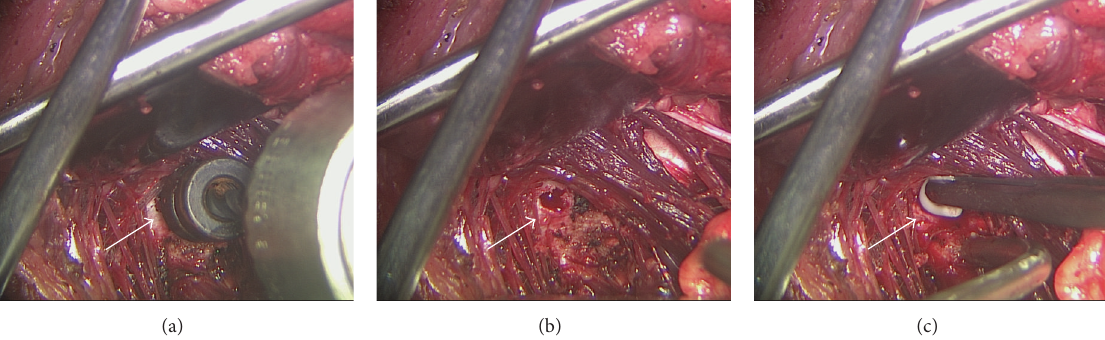
Figure 1: Vertebral bone defect: surgical procedure. Cylindrical bone defects were generated in the lumbar vertebrae of minipigs and treated with either BMP6-MSCs or fibrin gel only. A surgical drill was used to perform the defect in the lumbar vertebral body (a). A 4 mm in diameter, 15-mm deep, cylindrical defect was generated and prepared for construct implantation (b). BMP6-MSCs suspended in fibrin gel or fibrin gel only (control) constructs were implanted in the defect site (c). White arrows point to the location of the defect.